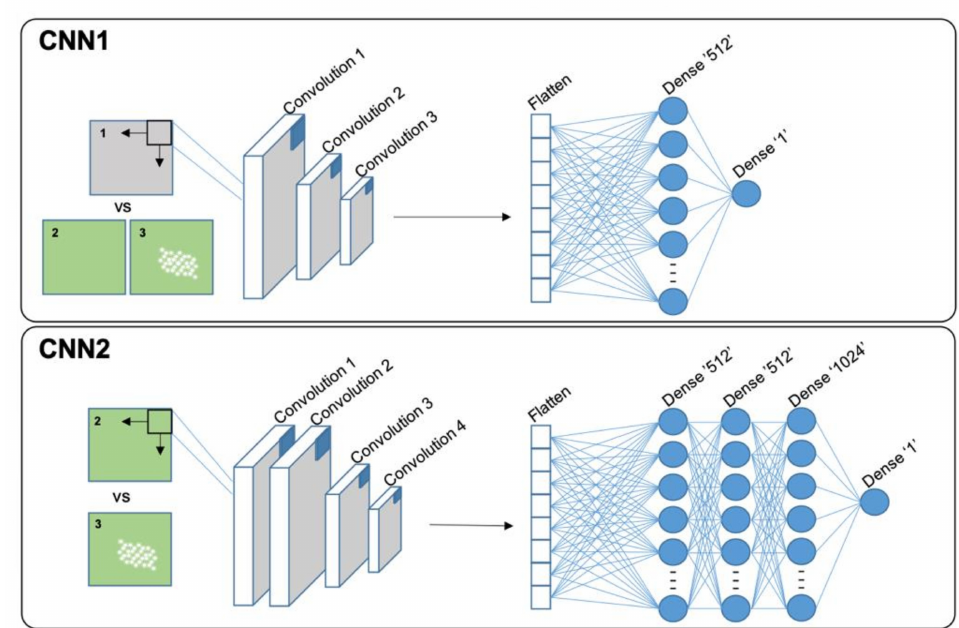
Figure 3. Structure of the two CNNs. Each convolution layer consists of: convolution (Cov2D), activation (ReLU = rectified linear unit activation function) and pooling (MaxPooling2D). The fully connected layers (“Dense”) also have the ReLU activation. The last “Dense” ‘1 (cid:48) layer has the Sigmoid activation function required for the binary output of the CNNs. The number of nodes in each “Dense” layer are